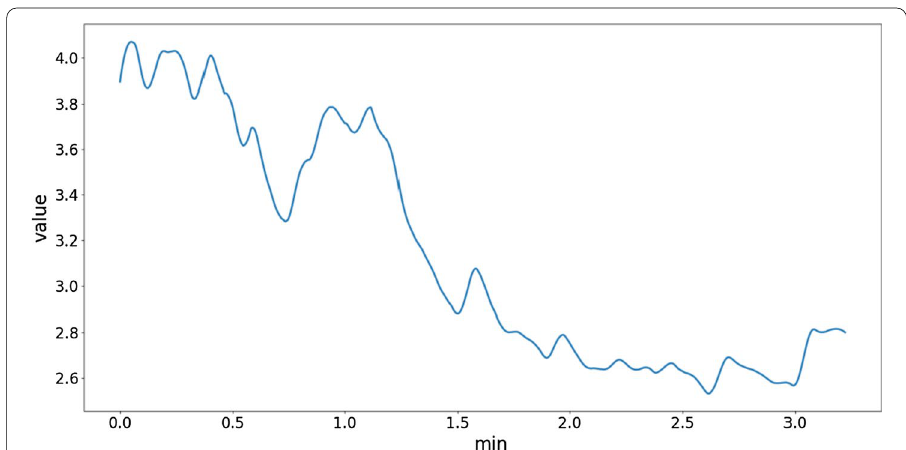
Fig. 11 The value of GSR after preprocessing for a subject